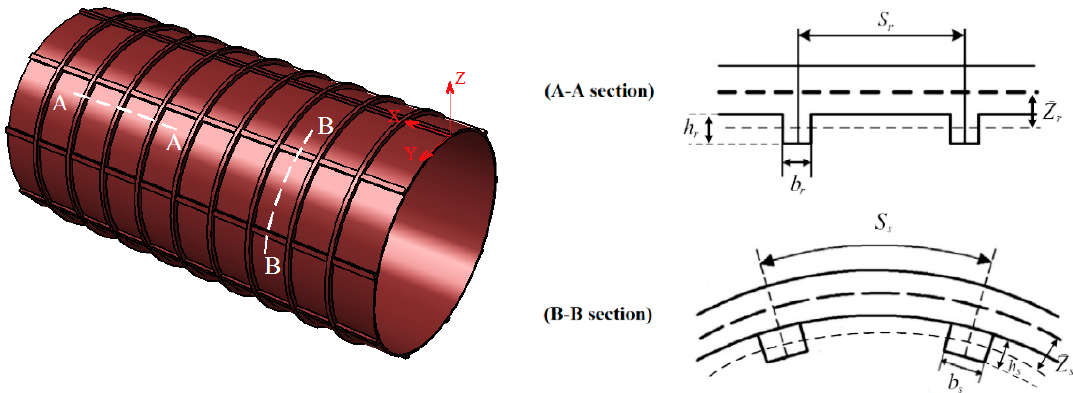
Figure 1. Geometrical scheme of a stiffened cylindrical shell.